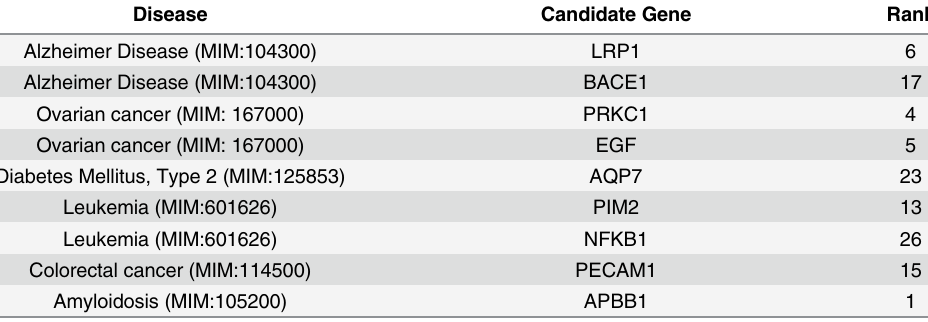
Table 3. The top ranked candidate genes for some instances. Disease